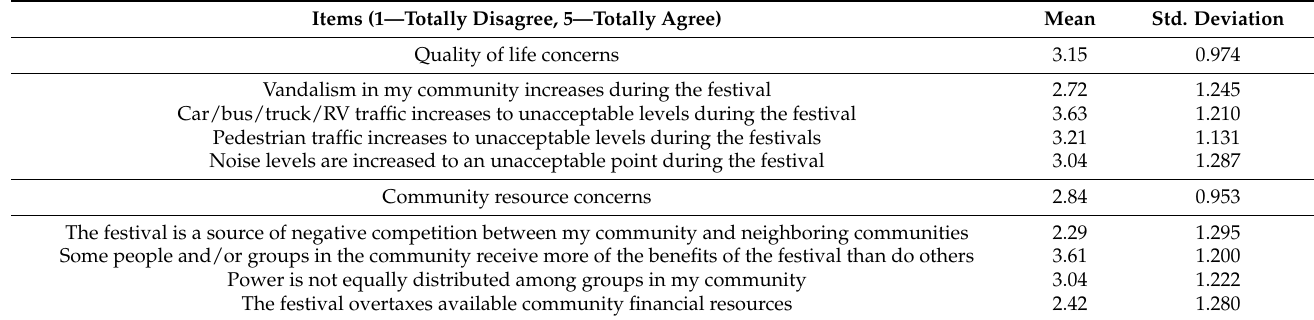
Table 3. Means and standard deviations of the items referring to the festival’s socio-cultural costs.